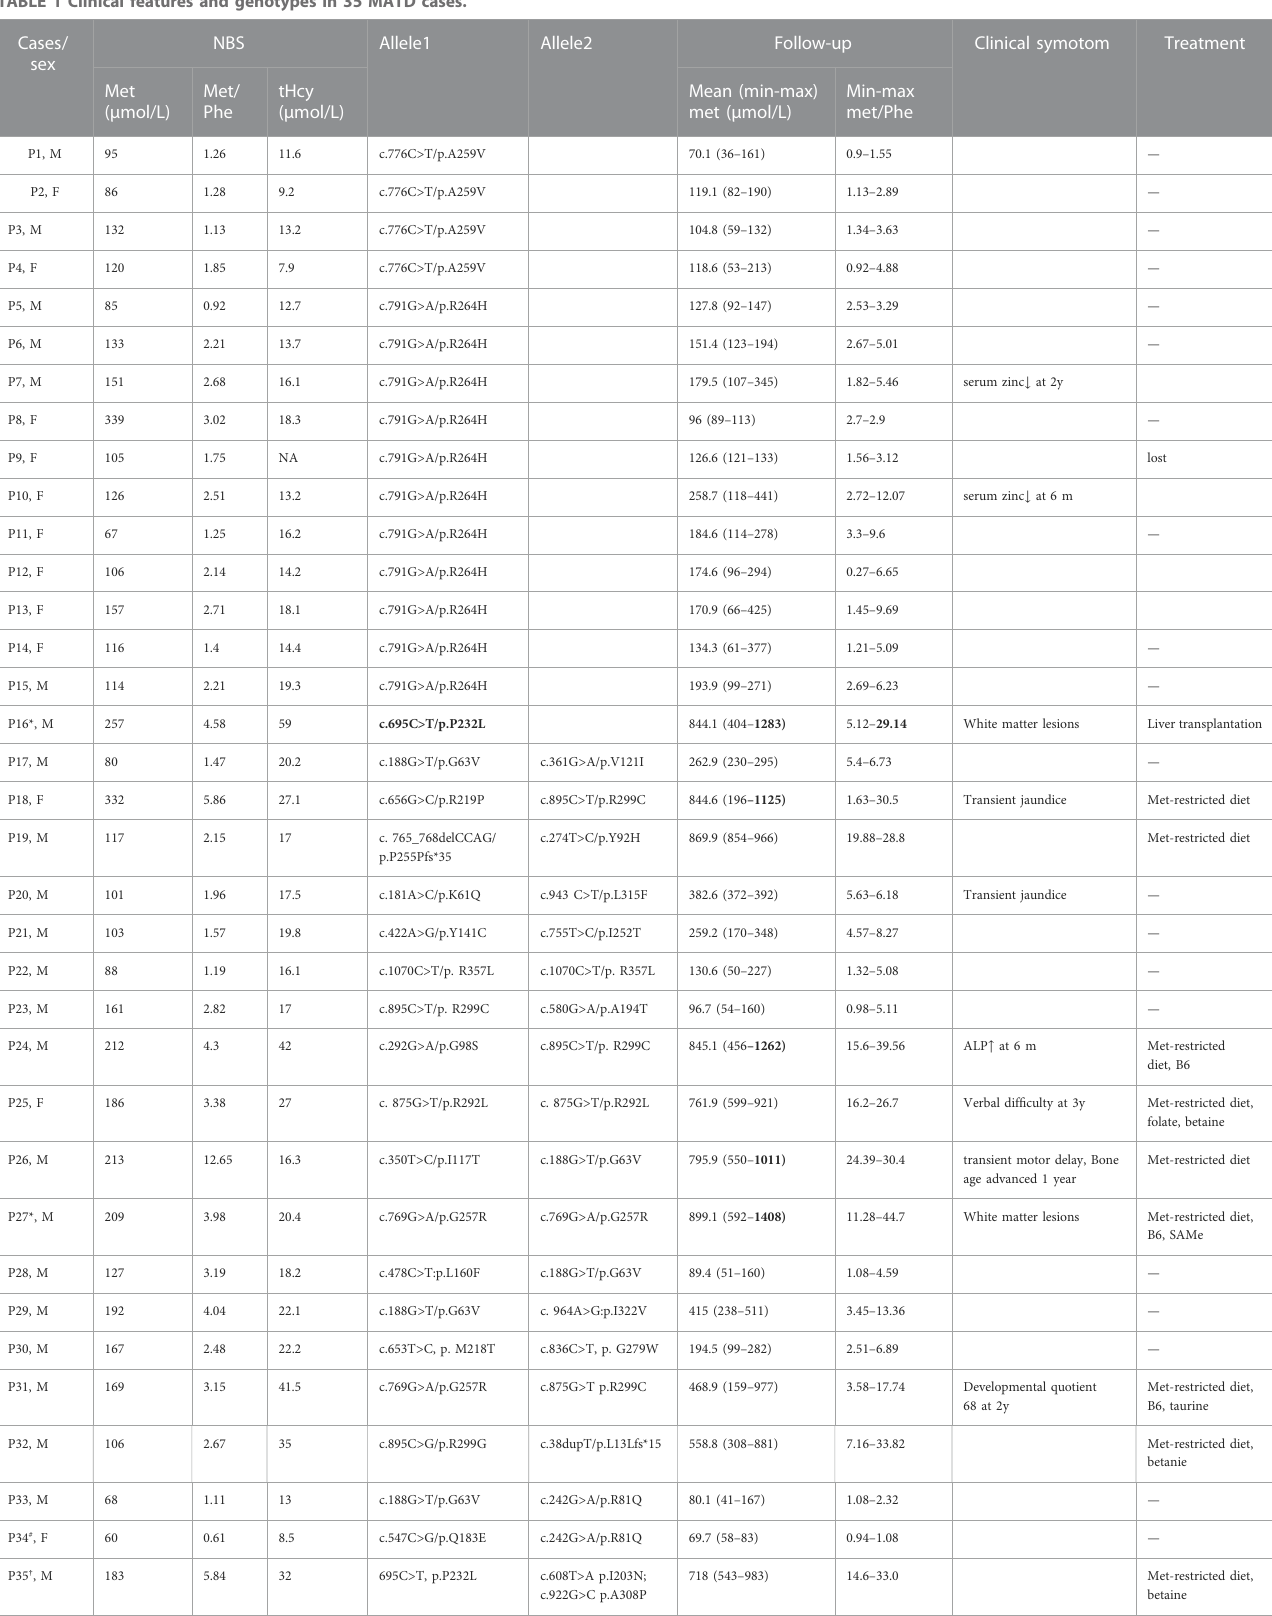
TABLE 1 Clinical features and genotypes in 35 MATD